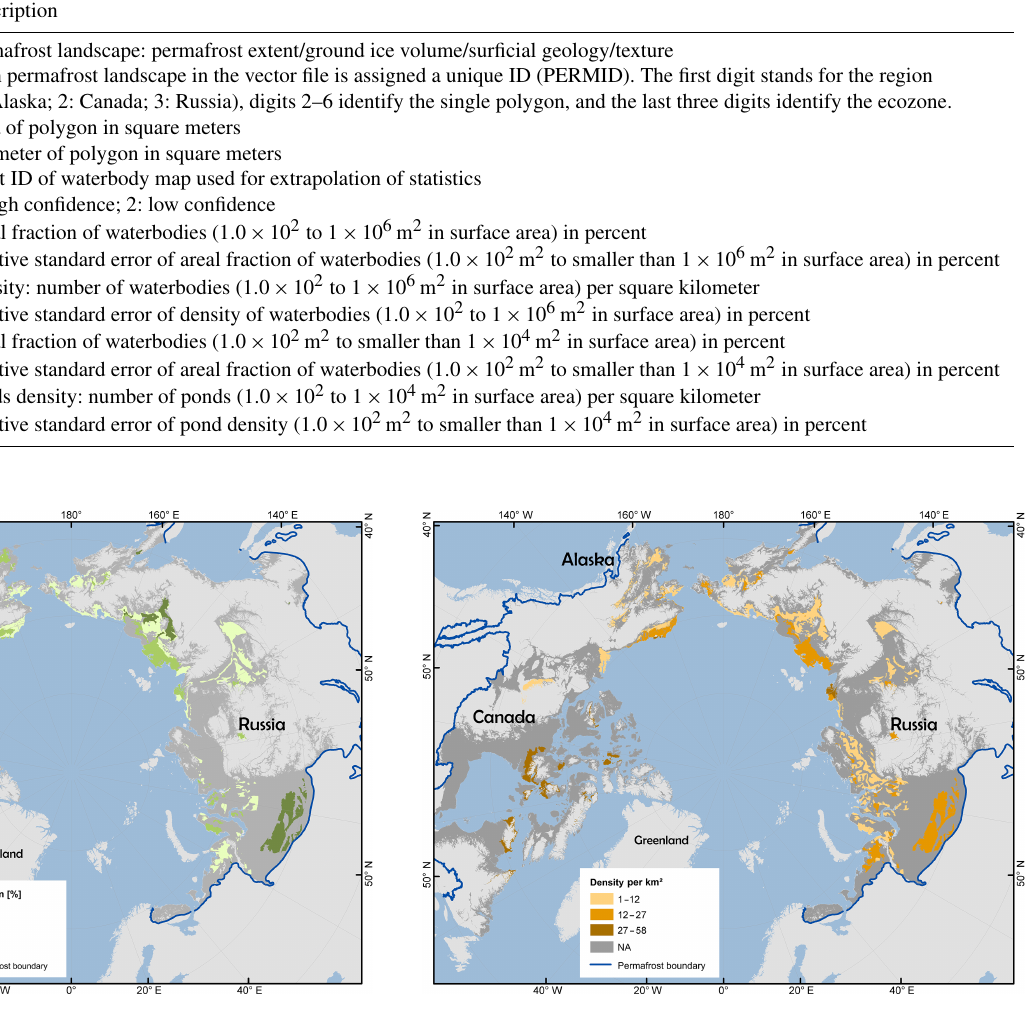
Figure 5. Waterbody density per square kilometer for waterbodies with surface areas of between 1 . 0 × 10 2 and 1 . 0 × 10 6 m 2 within permafrost landscape units. Permafrost boundary was derived from the regional